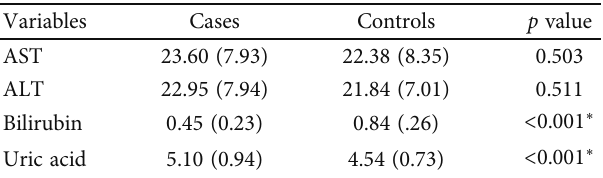
Table 2: Biochemical functions in study groups ( mean ± SD ).